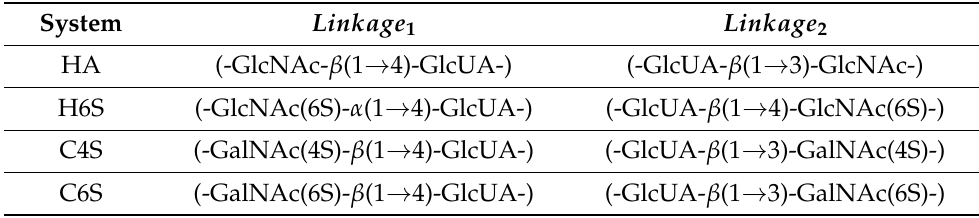
Table 1. The glycosidic linkage models of the GAG